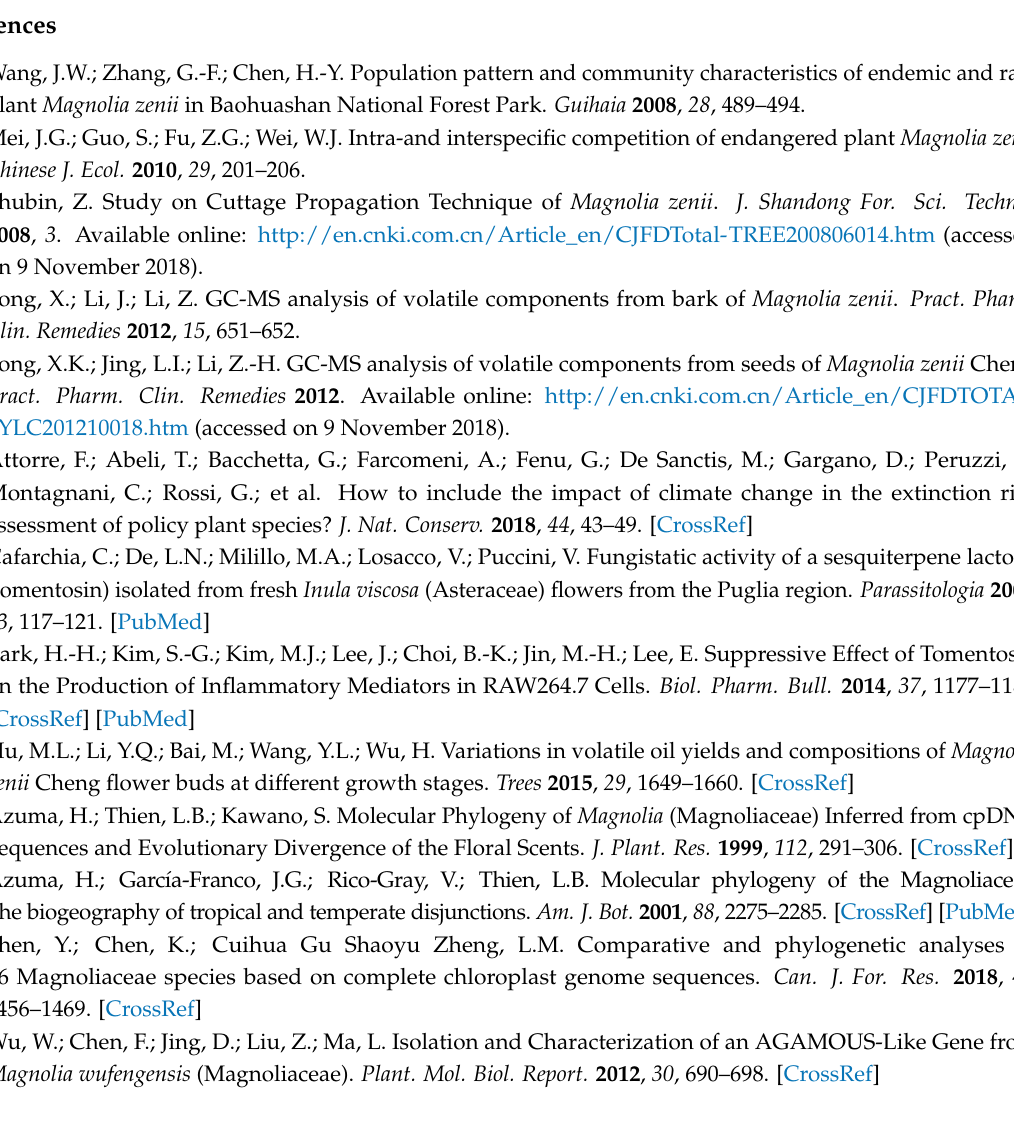
Supplementary Materials: The following are available online: Table S1: Summary of the plastid genome features of the 28 Magnolia and 2 Liriodendron species studied, Table S2: Base composition in the M. zenii plastid genome, Table S3: The length of exons and introns in genes with introns in the M. zenii plastid genome, Table S4: Codon-anticodon recognition patterns and codon usage of the M. zenii plastid genome, Table S5: Simple sequence repeats (SSRs) in the M. zenii plastid genome, Table S6. Long repeat sequence in the M. zenii plastid genome, Figure S1: Complete plastid genome comparison of 28 Magnolia and two Liriodendron species using the plastome of M. laevifolia as a reference. The grey arrows and thick black lines above the alignment indicate the genes’ orientation. The y-axis represents the percent identity between 50 and 100%. Red and blue areas indicate intergenic and genic regions, respectively, Figure S2: ML phylogenomic tree of 28 Magnolia (represented by 36 individuals) and 2 Liriodendron species. Numbers above the lines indicate the bootstrap support of each clade when